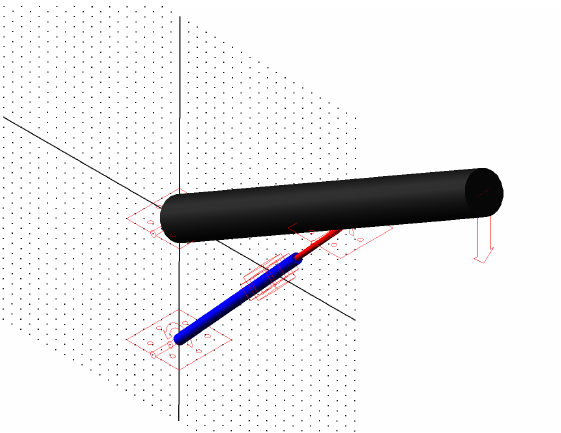
Figure 6. ADAMS model of mechanical